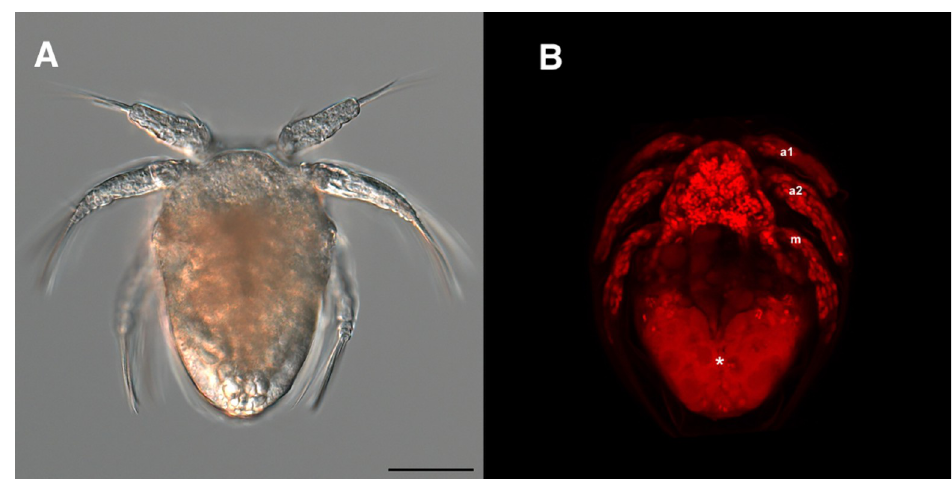
Fig 3. Images of Nauplius I stage larva of Ive ptychoderae ; (A) Bright-field image, and (B) fluorescent image by confocal microscopy with nucleus staining (red). (a1) Antennule; (a2) Antenna; (m) Mandible; ( � ) Yolky granules. Scale bar = 50 μ